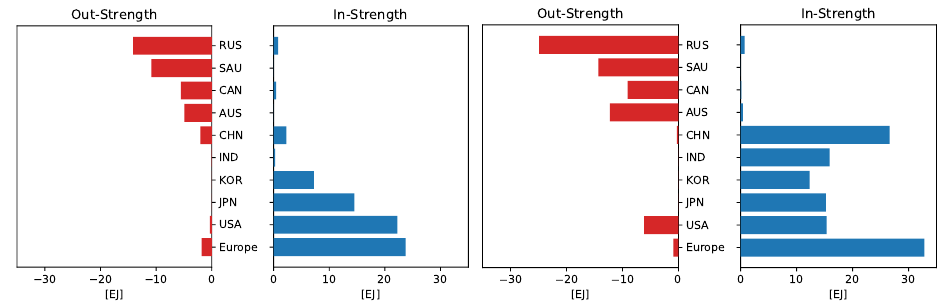
Figure 9. The change in the fossil fuels trade concentration from 2001 ( left ) to 2018 ( right ).